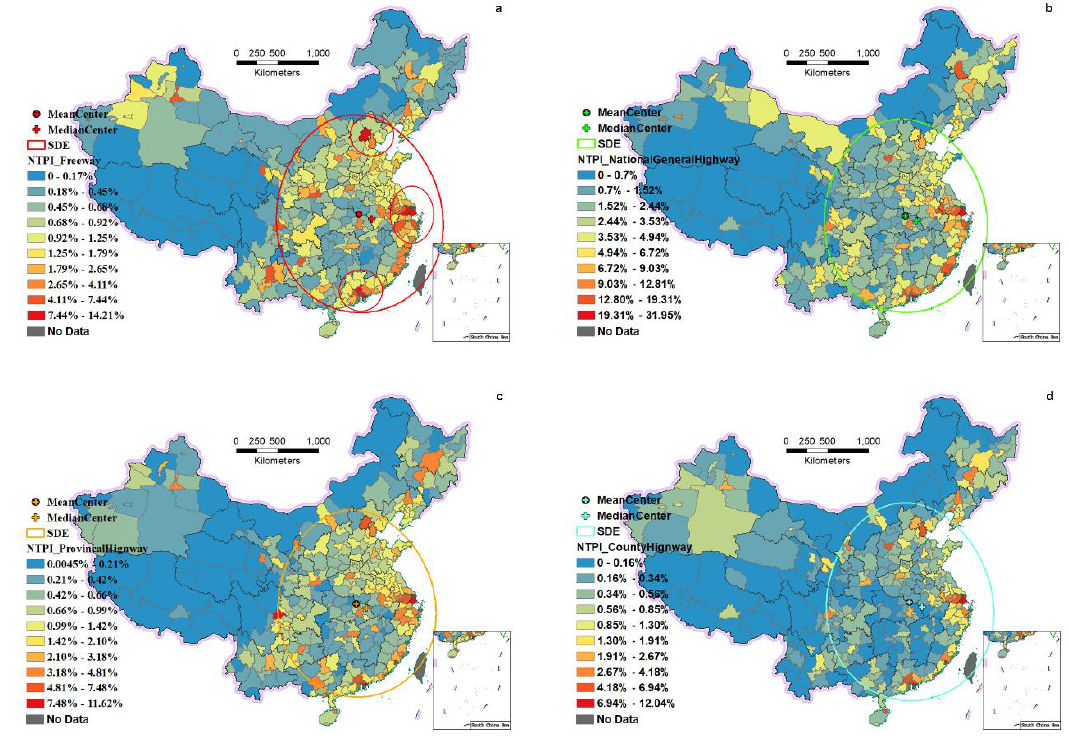
Figure 12. The standard deviation ellipse distribution of NTPI for four highway grades: ( a ) is the SDE of NTPI for national freeway; ( b ) is the SDE of NTPI for national general highway; ( c ) is the SDE of NTPI for provincial highway; ( d ) is the SDE of NTPI for county highway.